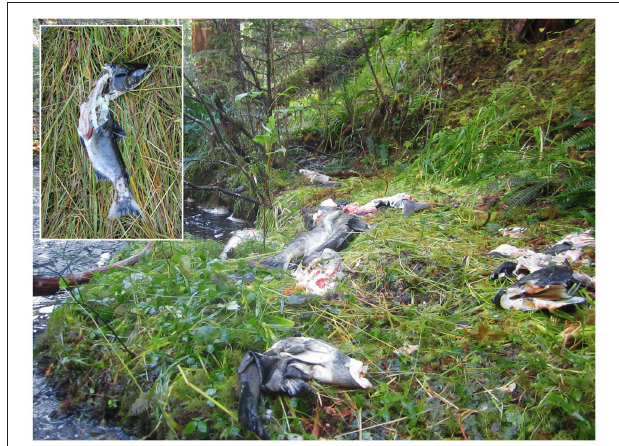
FIGURE 3 | Bear-transferred carcasses with tears to body and trunk muscles tissue and eggs often consumed. Photo credit: Ben Rabinovitch (main), Morgan Hocking